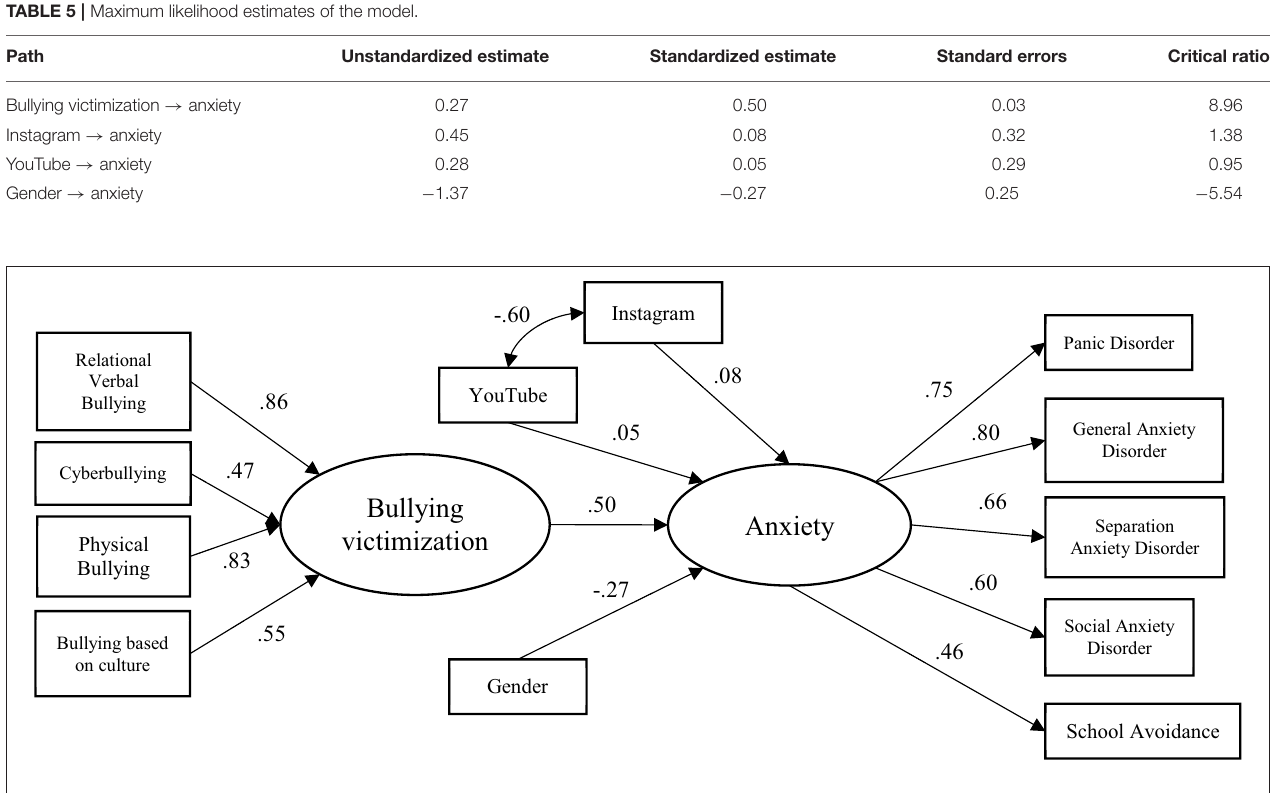
FIGURE 1 | Structural equation model between